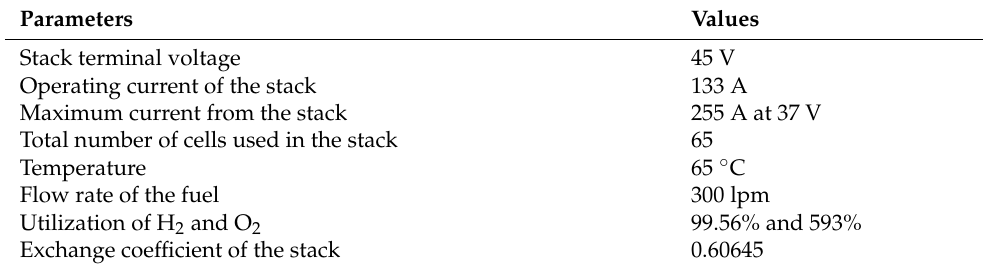
Table 1. Fuel-cell parameters [7].